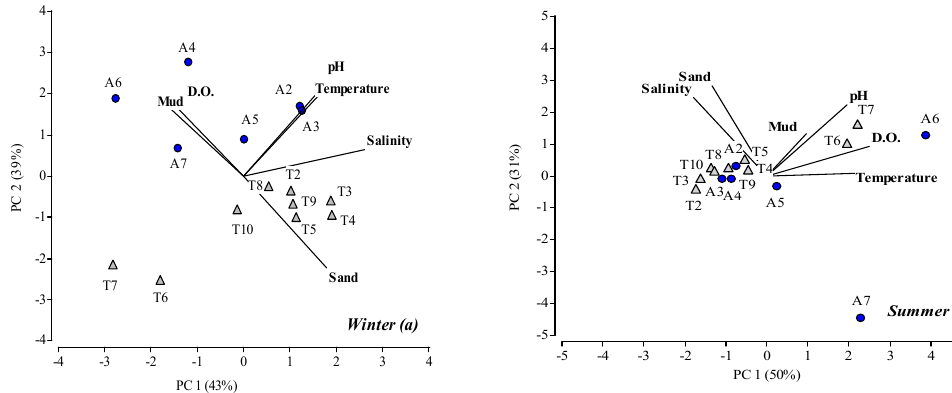
Figure 5. Vector diagram that indicates the loading on PC1 and PC2 of the variables salinity, pH, temperature, dissolved oxygen content, mud, and sand during winter ( a ) and summer ( b ).